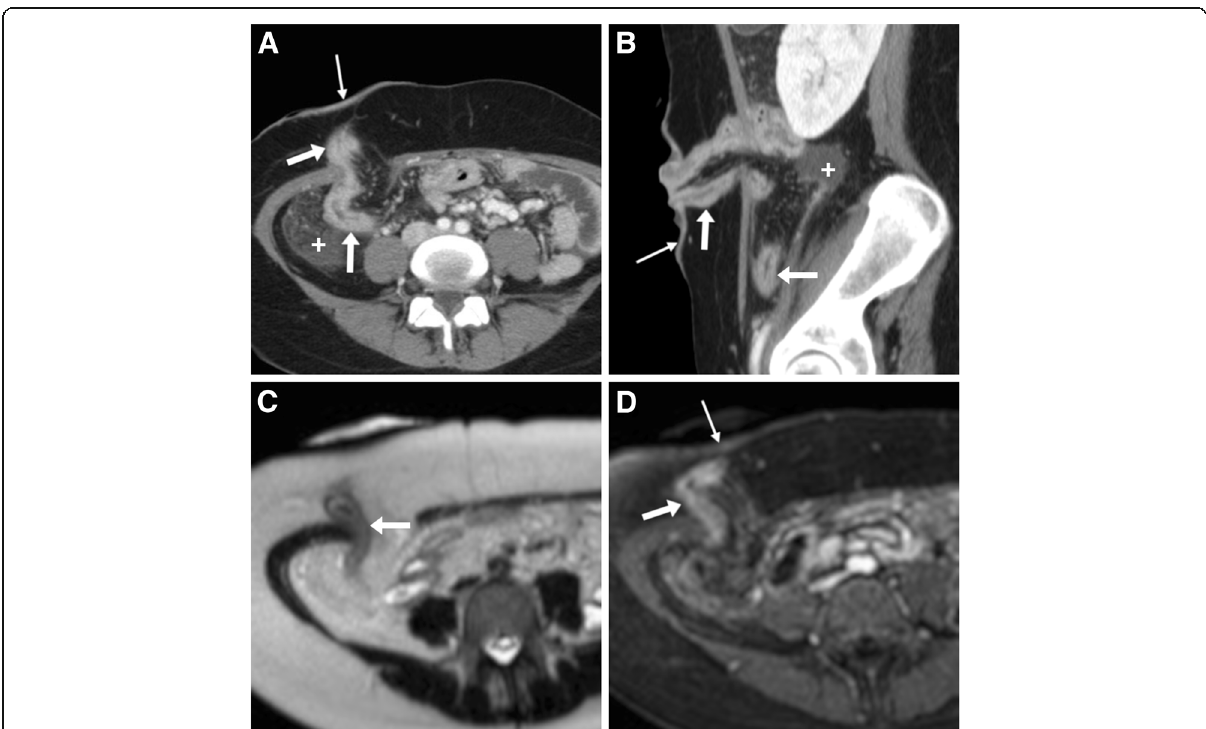
Fig. 12 Reactivation of Crohn ’ s disease at an ileostomy. a , b CT showing diffuse, mildly irregular mural thickening with marked contrast enhancement along the stomal tract and the distal small bowel, consistent with active disease (also note fat stranding and fluid in the right parietocolic gutter). c , d In the same patient, MR-enterography confirms thickened walls on T2-weighted ( c ) with hyperenhancement on post-gadolinium fat-suppressed ( d ) images. Additionally, note enhancing inflamed peristomal skin (thin arrows in a , b and d )